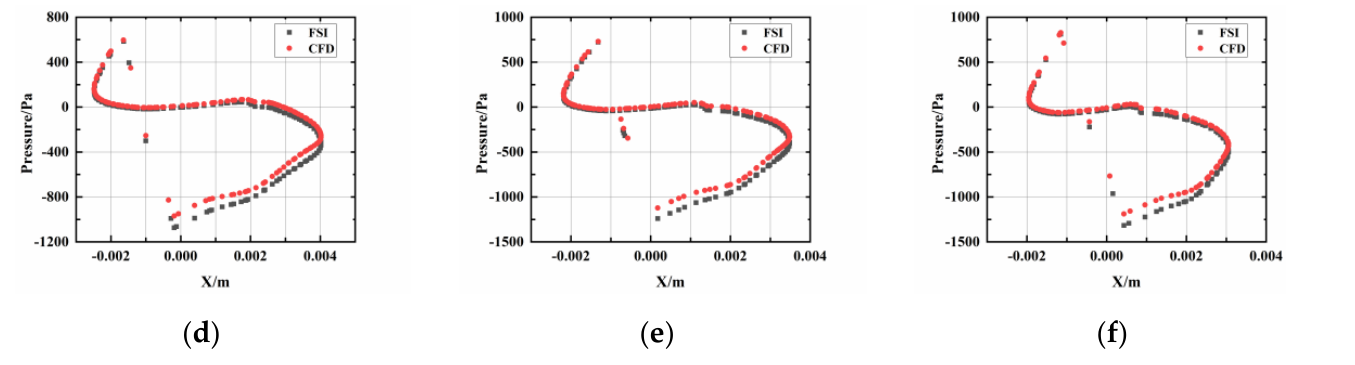
Figure 7. Pressure distribution of different blade sections: ( a ) span = 20%, ( b ) span = 40%, ( c ) span = 50%, ( d ) span = 60%, ( e ) span = 70%, and ( f ) span = 80%.